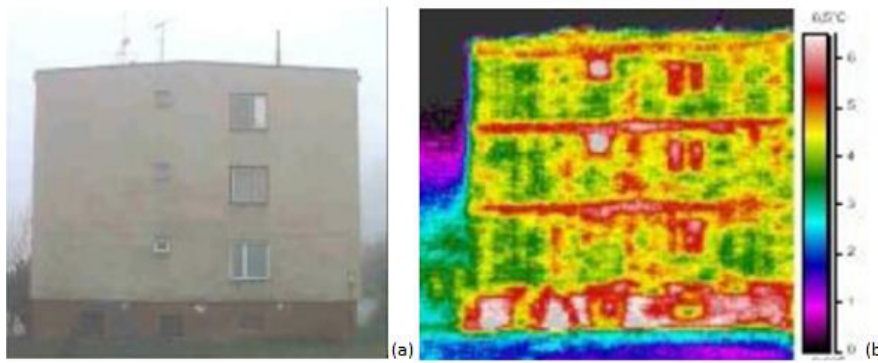
Figure 2. Representative image of one of few hundreds explored buildings ( a ) before thermomodernization and ( b ) its thermogram indicating heat flows.